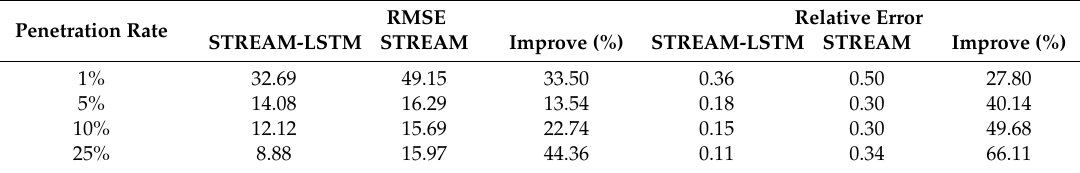
Table 4. Evaluation results for the proposed method (link